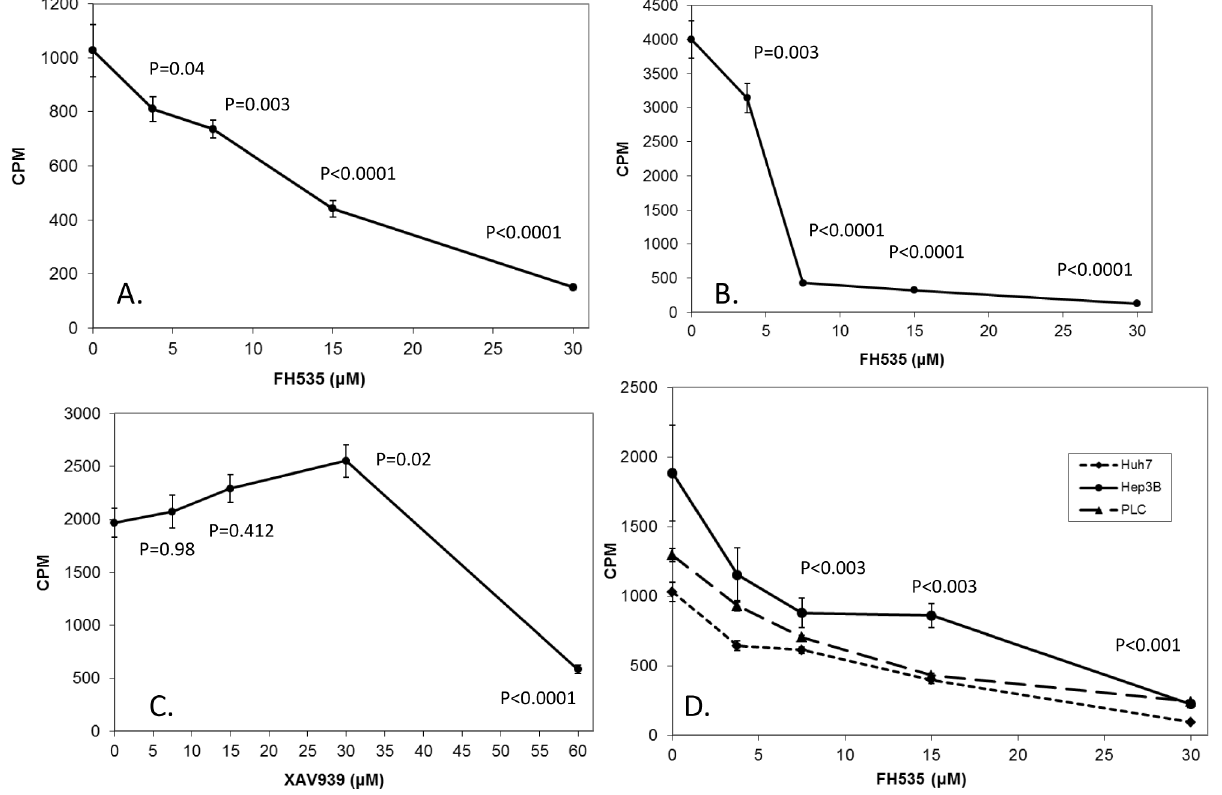
Figure 3. FH535 inhibits proliferation of LCSC and HCC cell lines . Cells were seeded in 96-well plates in 0.2 ml of media as described below for 72 hours, followed by the addition of 3 H-thymidine at 1 m Ci/well for 4 hours. Incorporation of 3 H-thymidine was determined by scintillation counting. In panels A, B and D, the final concentration of DMSO in each well was 0.05%; in panel C, the final DMSO concentration in each well was 0.1%. ( A ) LCSCs were plated at 1000 cells/well in DMEM with 10% FBS along with DMSO alone or with increasing amounts of FH535. ( B ). LCSCs were plated at 5000 cells/well in DMEM with 1% FBS with DMSO alone or with increasing concentrations of FH535. ( C ). LCSCs were plated in DMEM with 10% FBS at 1000 cells/well with DMSO alone or increasing concentrations of XAV939. ( D ). Huh7, Hep3B and PLC cells were plated in DMEM with 10% FBS at 1000, 2500, and 5000 cells/well, respectively, with DMSO alone or increasing concentrations of FH535. P values are for all the three cell lines treated with FH535 are compared to controls. The experiment was done twice with similar results. doi:10.1371/journal.pone.0099272.g003 PLOS ONE |